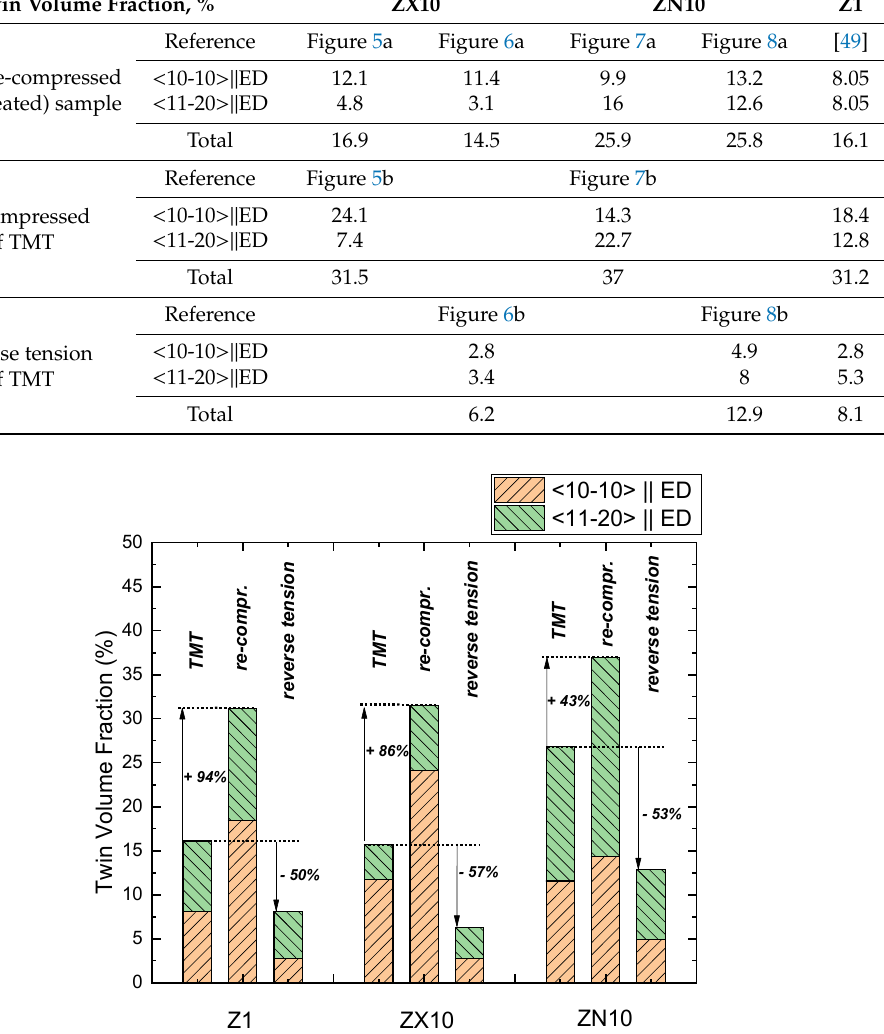
Table 2. Twin volume fraction (TVF) for grains with their < 10-10 > or < 11-20 > axis parallel to the loading axis in the TMT state of ZX10, ZN10, and Z1 [49] alloys. The evaluation error of TVF values for each sample is about 4%.